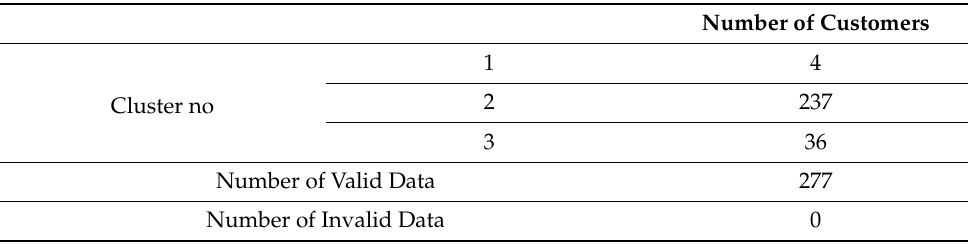
Table 4. Number of customers at any cluster as variable of second error (source: research analysis).